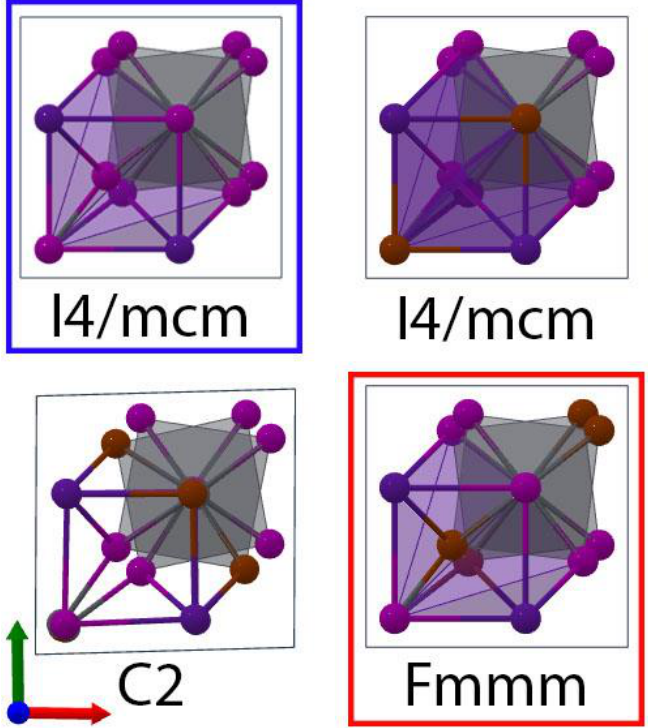
Figure 3. The crystal structures of the β -CsPbI 3 I4/mcm (blue box) and β -CsPbI 2 Br F mmm (red box) phases and all other β -CsPbI 2 Br phases considered. The perspective is down the c -axis of the crystals with the lead atoms eclipsed by halides to better represent the halide substitutions. In this case, the system of coordinates was also rotated so that a and b became aligned with Pb-X bonds for easy comparison to Figure 1.